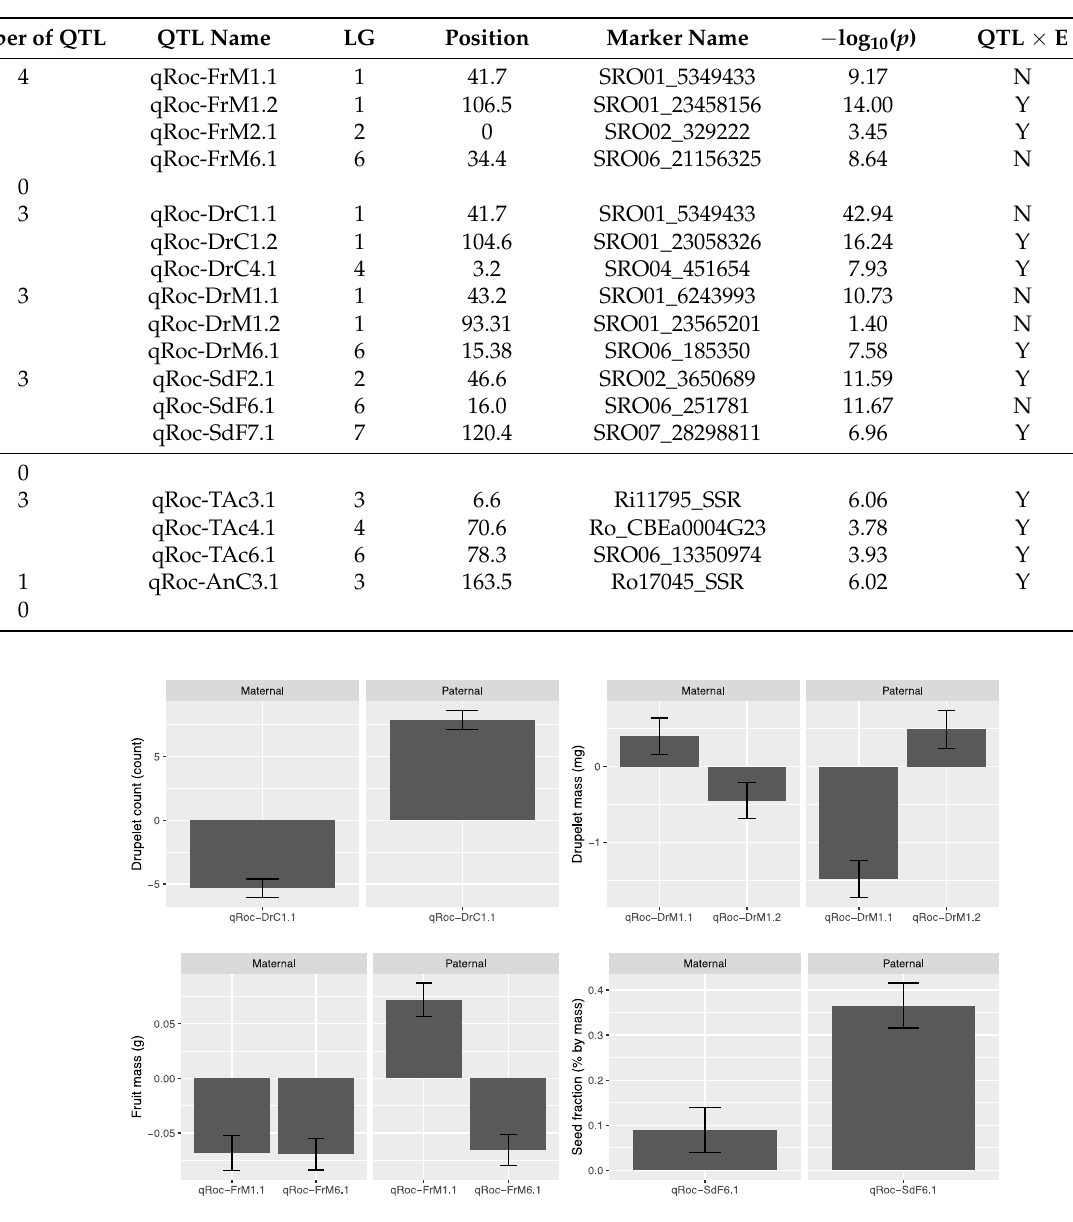
Figure 4. Additive effect size of stable QTL identified by multiple-environment analysis. Error bars indicate standard error.